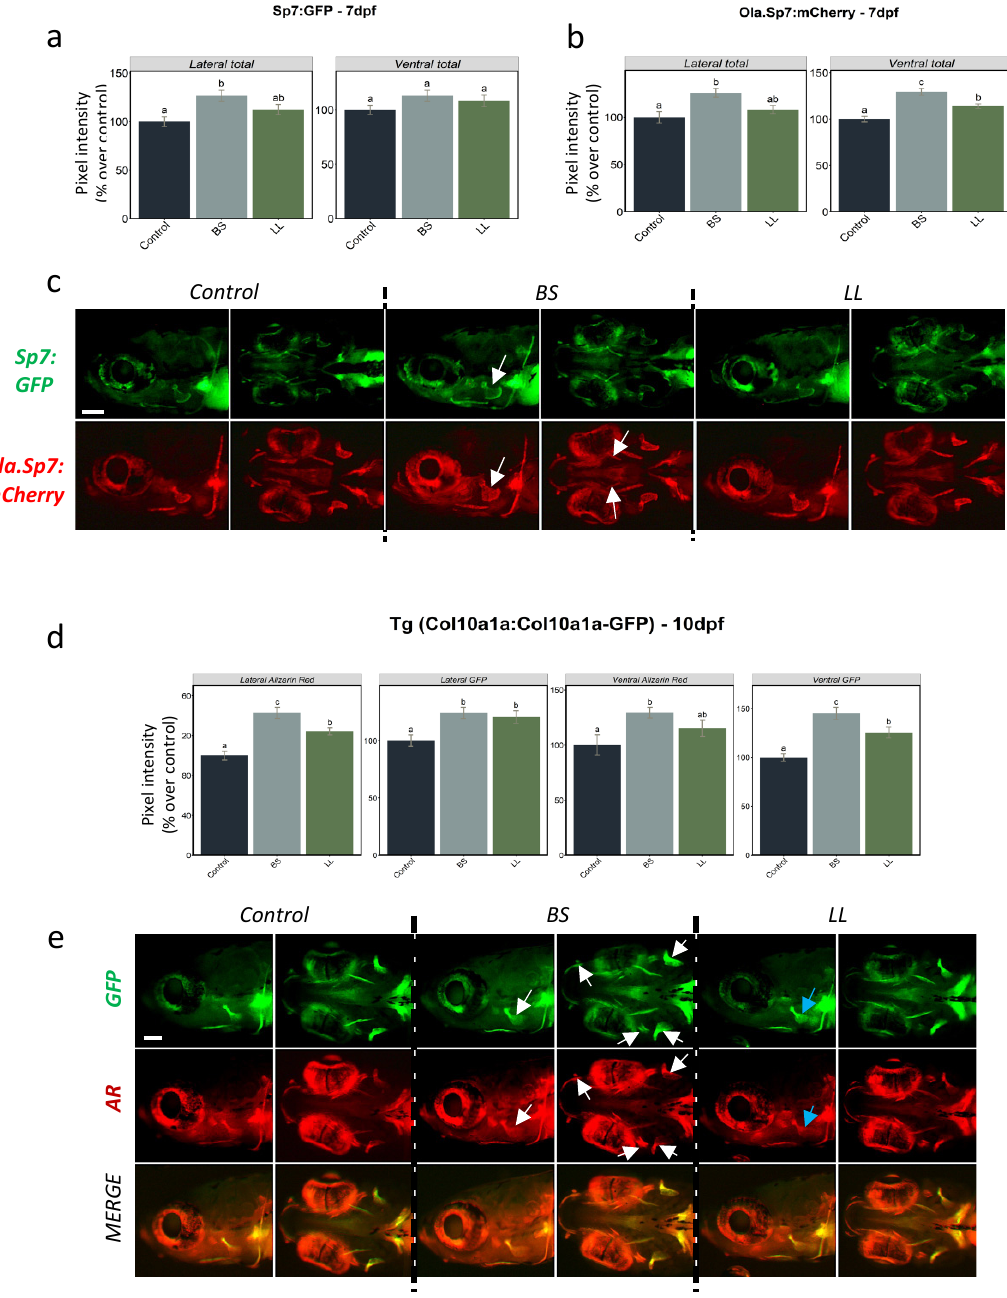
Figure 4. Integrated pixel intensity values for various areas measured in 7 dpf zebrafish from ( a ) Tg(sp7:sp7-GFP) and ( b ) Tg(Ola.Sp7:mCherry) larvae in controls and upon two different probiotic treatments. ( c ) Signal expression images (lateral and ventral views) of the head area of Tg(sp7:sp7-GFP) and Tg(Ola.Sp7:mCherry) larvae under the different conditions. ( d ) Integrated pixel intensity values for various areas measured in 10 dpf Tg(col10a1a:col10a1a-GFP) zebrafish larvae from the different treatment groups and stained with AR. ( e ) GFP, AR fluorescence and merged images of the head area (lateral and ventral views) of Tg(col10a1a:col10a1a-GFP) larvae from the different treatment groups. Increased GFP and AR fluorescence in various bony structures are denoted by white and blue arrows, respectively, in BS- and LL-treated fish. One-way ANOVA and Tukey’s multiple comparison tests are used, and statistical significance was set at p < 0.05. Different letters denote statistically significant differences between experimental groups. The scale bars, given in the left bottom corner of the first image in the top row, correspond to 100 µ